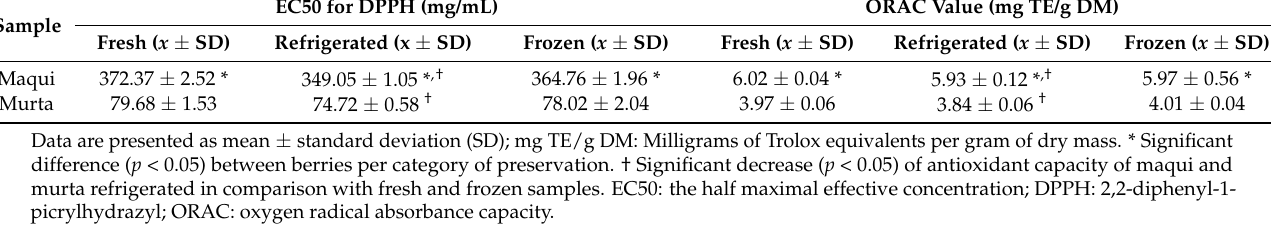
Table 1. DPPH and ORAC assay results for maqui and murta extracts in three categories of preservation.